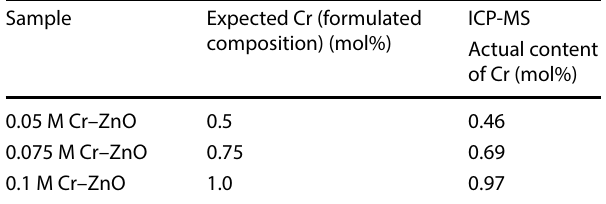
Table 2 Doping concentration of chromium obtained from ICP-MS result Sample